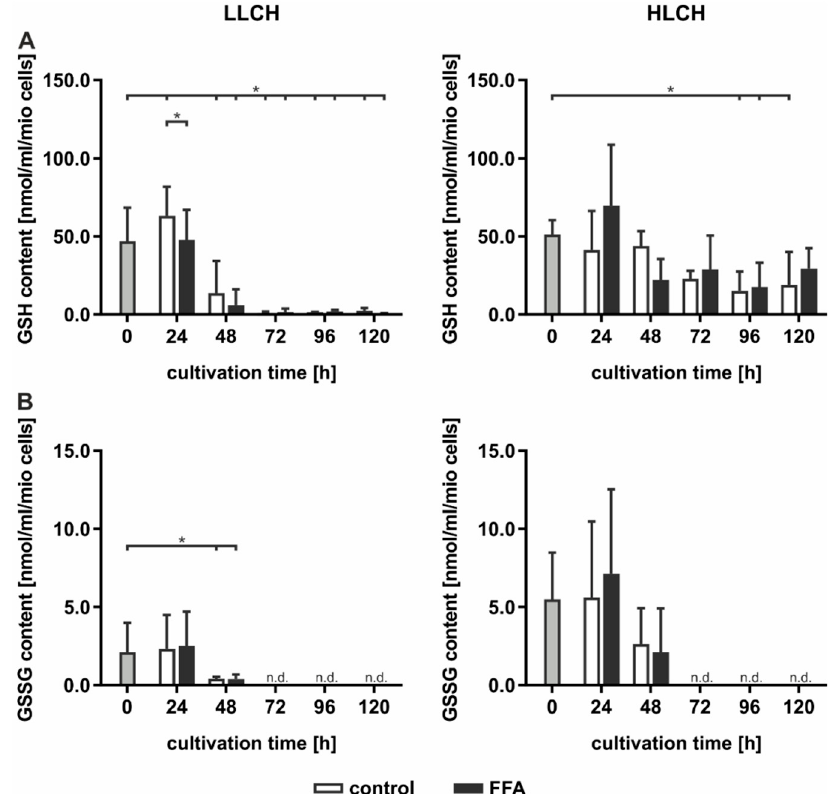
Figure 4. Measurement of the glutathion (GSH) and glutathione disulfide (GSSG) concentrations in the LLCH (donors 1–3) and HLCH (donors 4–6) depending on free fatty acid (FFA) treatment. ( A ) GSH and ( B ) GSSG (which was not detectable (n.d.) from 72 to 120 h) were quantified using Ellmann’s assay. Data are shown as the means ± SD, n = 3, two-way ANOVA, and post hoc Dunnett or Bonferroni analysis. A p value of 0.05 or less (*) was considered significant. For the details on the statistical evaluation, see Table S1D.